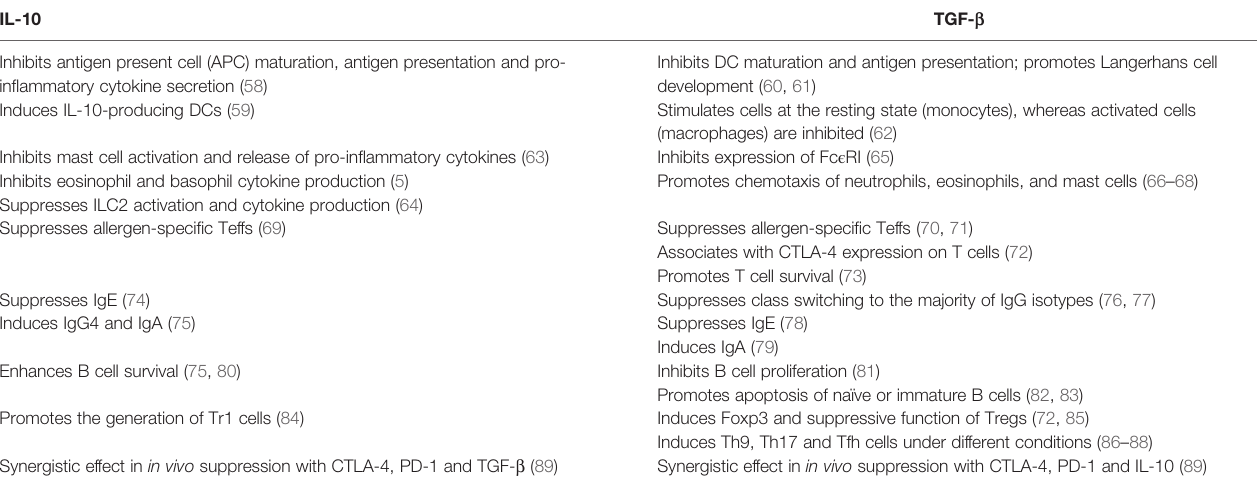
Inhibits DC maturation and antigen presentation; promotes Langerhans cell development (60, 61)